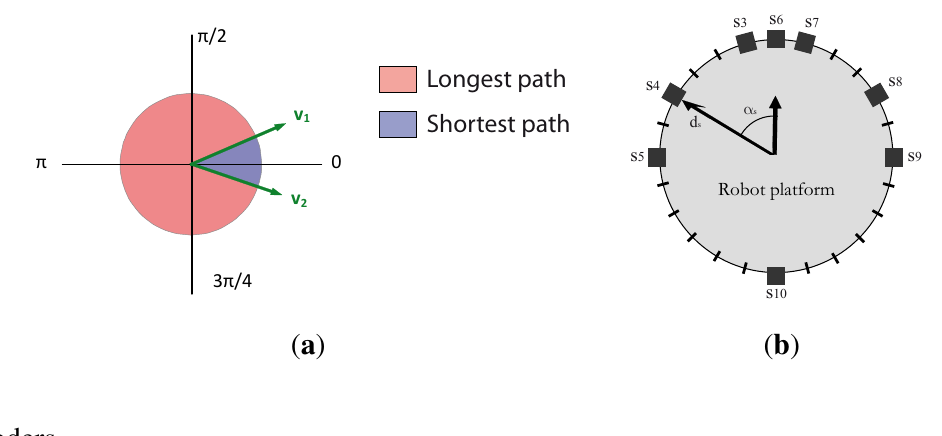
Figure 3. Sensor Models. ( a ) Orientation; ( b ) Ultrasonic